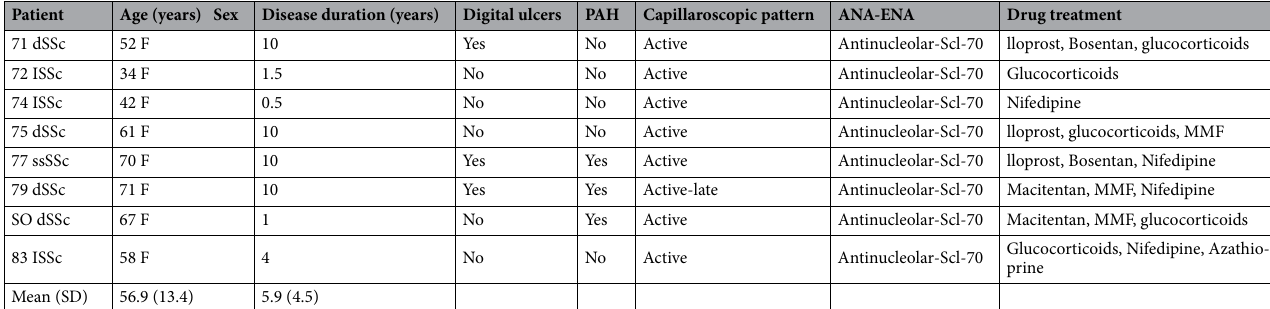
Table 1. The demographic and clinical characteristics of the patients enrolled in this study. MMF, Mycophenolate mofetil; SD, Standard